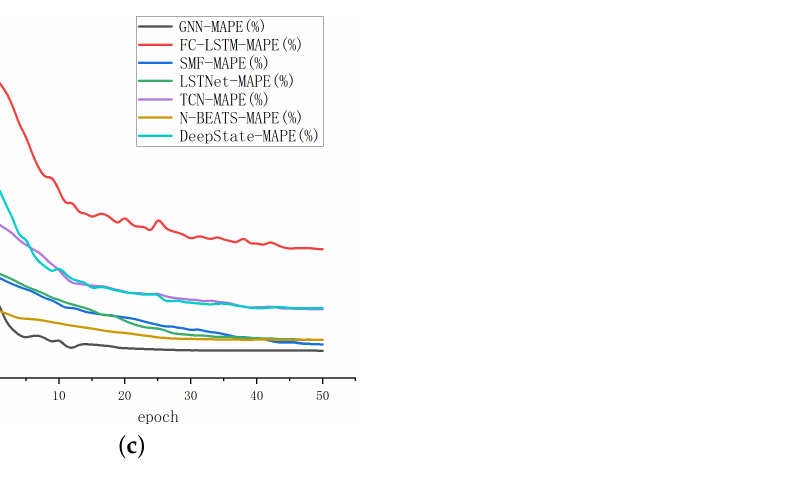
Figure 5. Iterative comparison. ( a ) is the result under MAE; ( b ) is the result under RMSE; ( c ) is the result under MAPE.